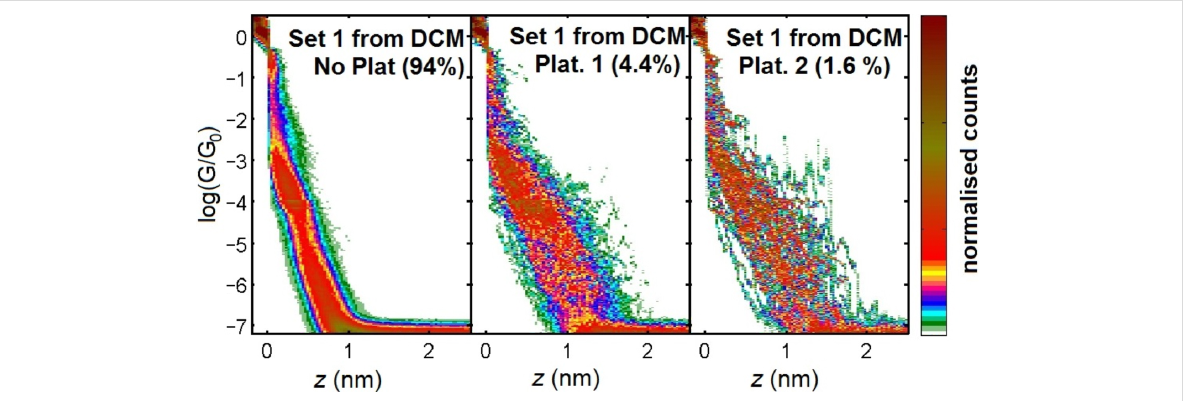
Figure 5: 2D histograms corresponding to compound 5 after exposing a gold substrate to a solution of the compound in DCM. The traces were sep- arated into three groups as described in Figure 4. The total number of traces recorded was 3830.